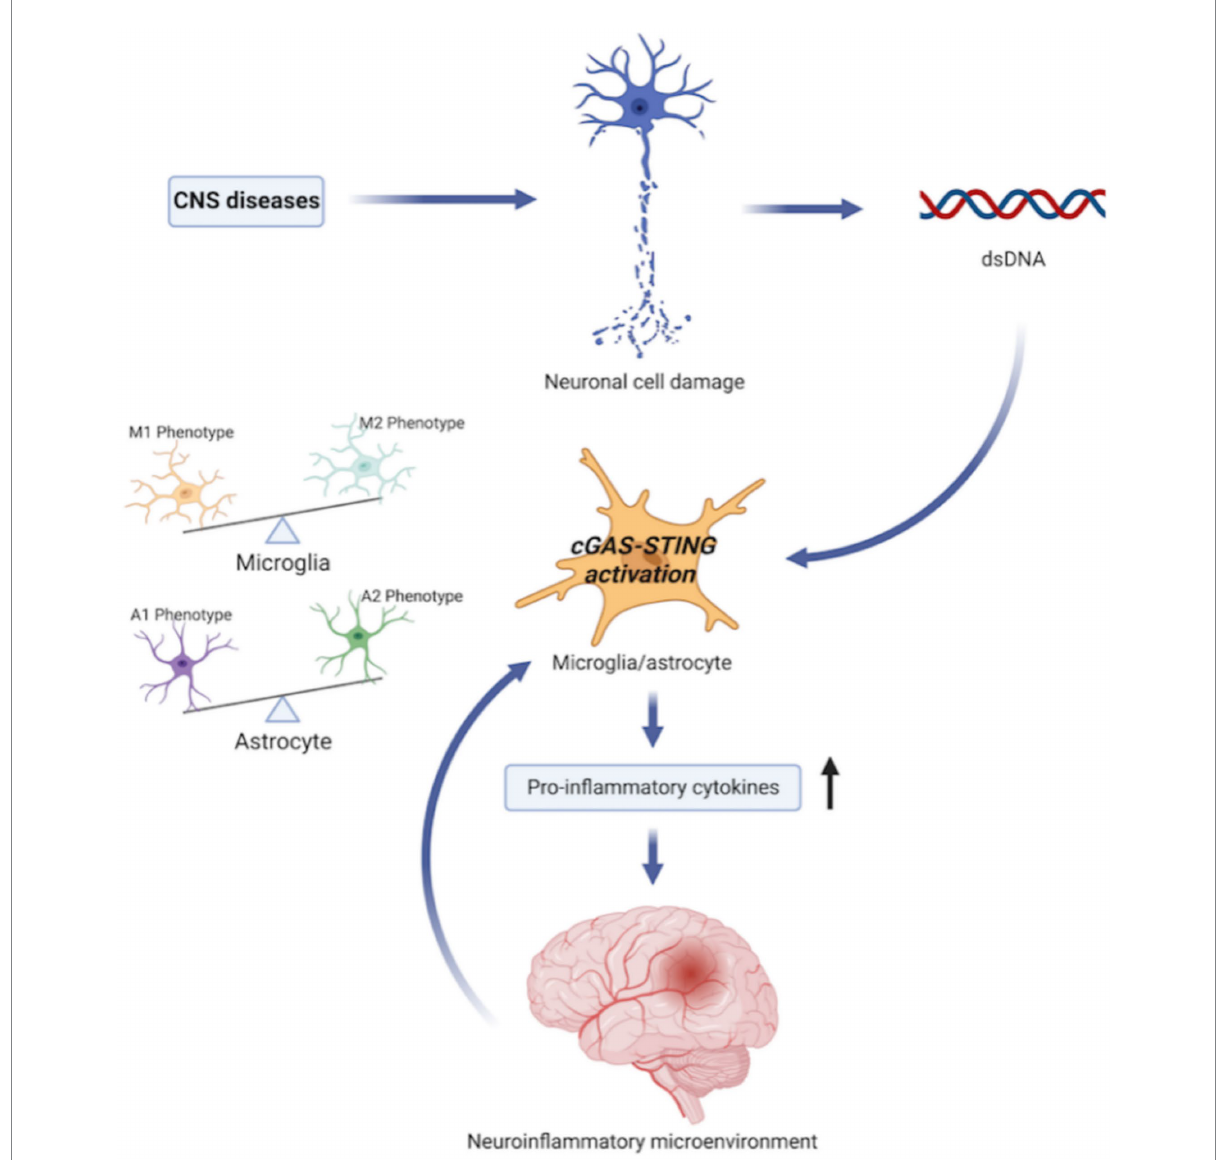
FIGURE 2 cGAS–STING pathway and neuroinflammation. Central nervous system (CNS) diseases, such as ischemic stroke, neurodegenerative disorders, traumatic brain injury etc., cause neuronal cell damage and releases dsDNA, including cytosolic DNA and mitochondrial DNA. dsDNA acts on neighboring microglia and astrocytes to activate intracellular cGAS–STING signaling pathway. Meanwhile, the activation of cGAS–STING pathway encourages microglia and astrocyte to secret proinflammatory cytokines, and affects the inflammatory phenotype of microglia and astrocytes, which creates a necessary neuroinflammatory microenvironment for the development of CNS diseases. In addition, disruption of neuroinflammatory microenvironment homeostasis may in turn affects the balance of pro-inflammatory and anti-inflammatory phenotypes of microglia and